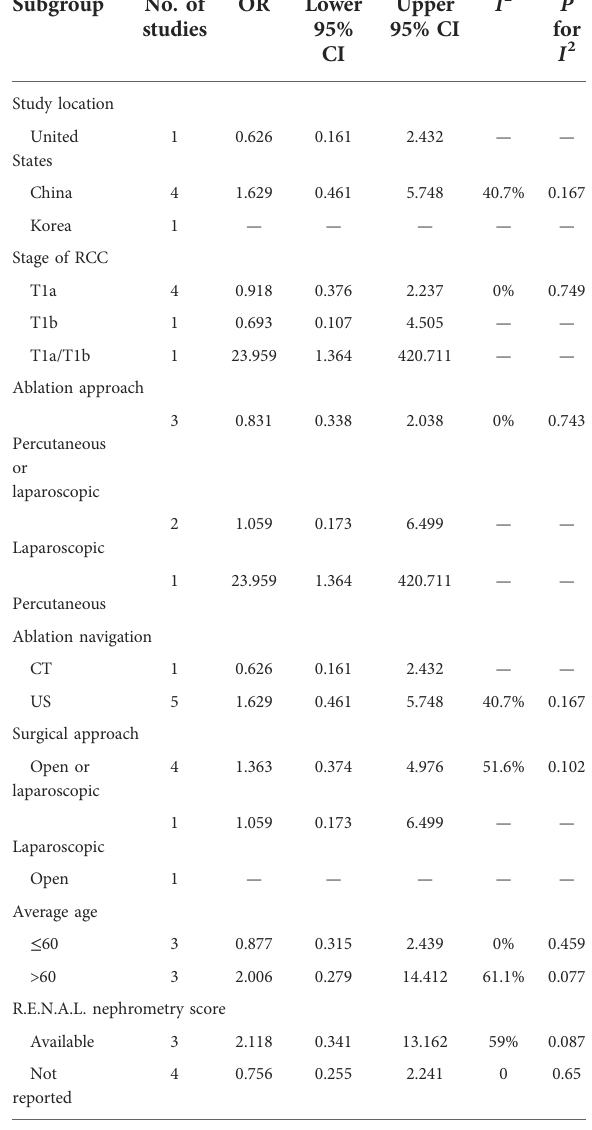
TABLE 3 Subgroup analysis for